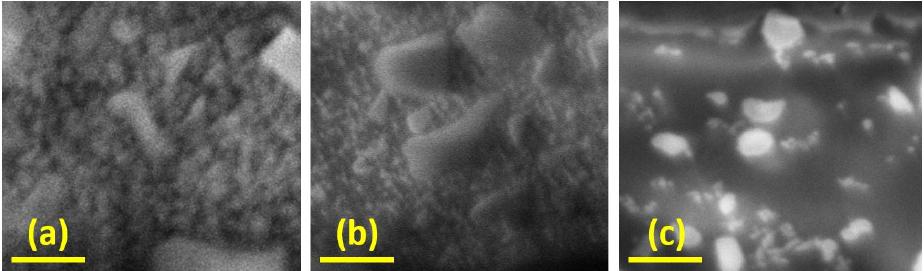
Figure 3. SEM images of the surfaces of ( a ) the Bisco Ortho Bracket Paste LC (Bisco), ( b ) Light-Cure Orthodontic Paste (Leone), and ( c ) Transbond XT TM Light Cure Adhesive (Trans) collected at a tilt angle of 52°. The scale bars indicate 10 μ m.